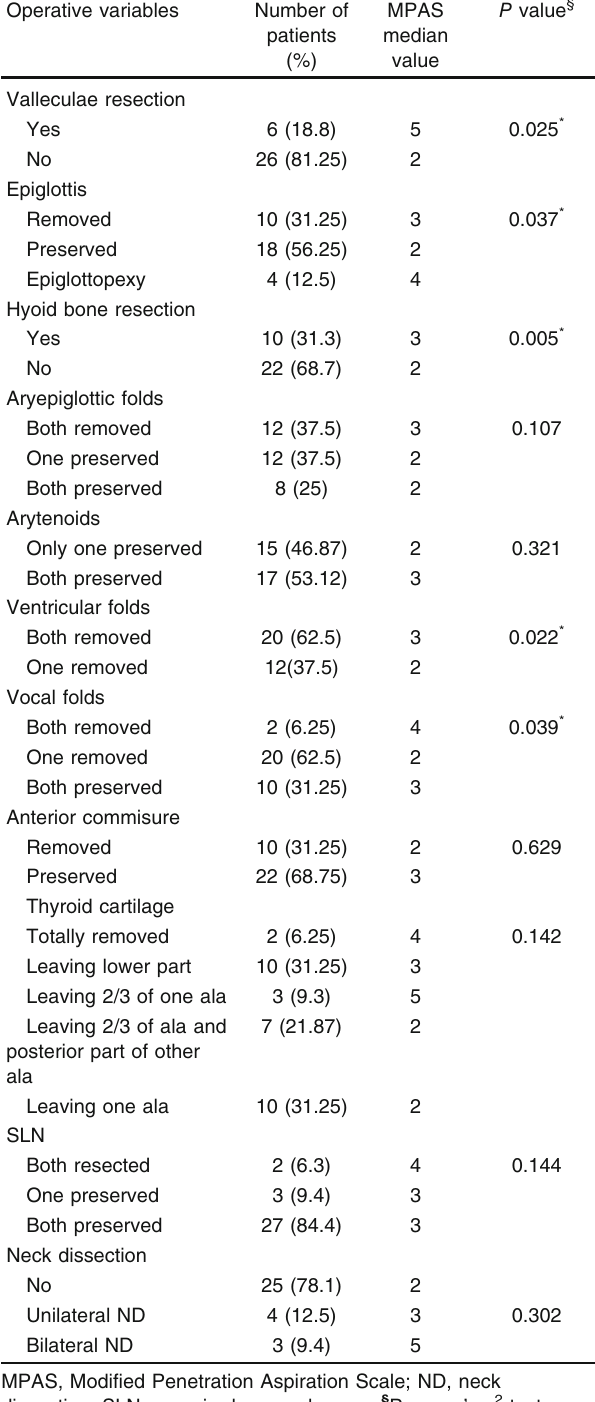
Table 5 Operative variables and their association with postoperative aspiration Operative variables Number of